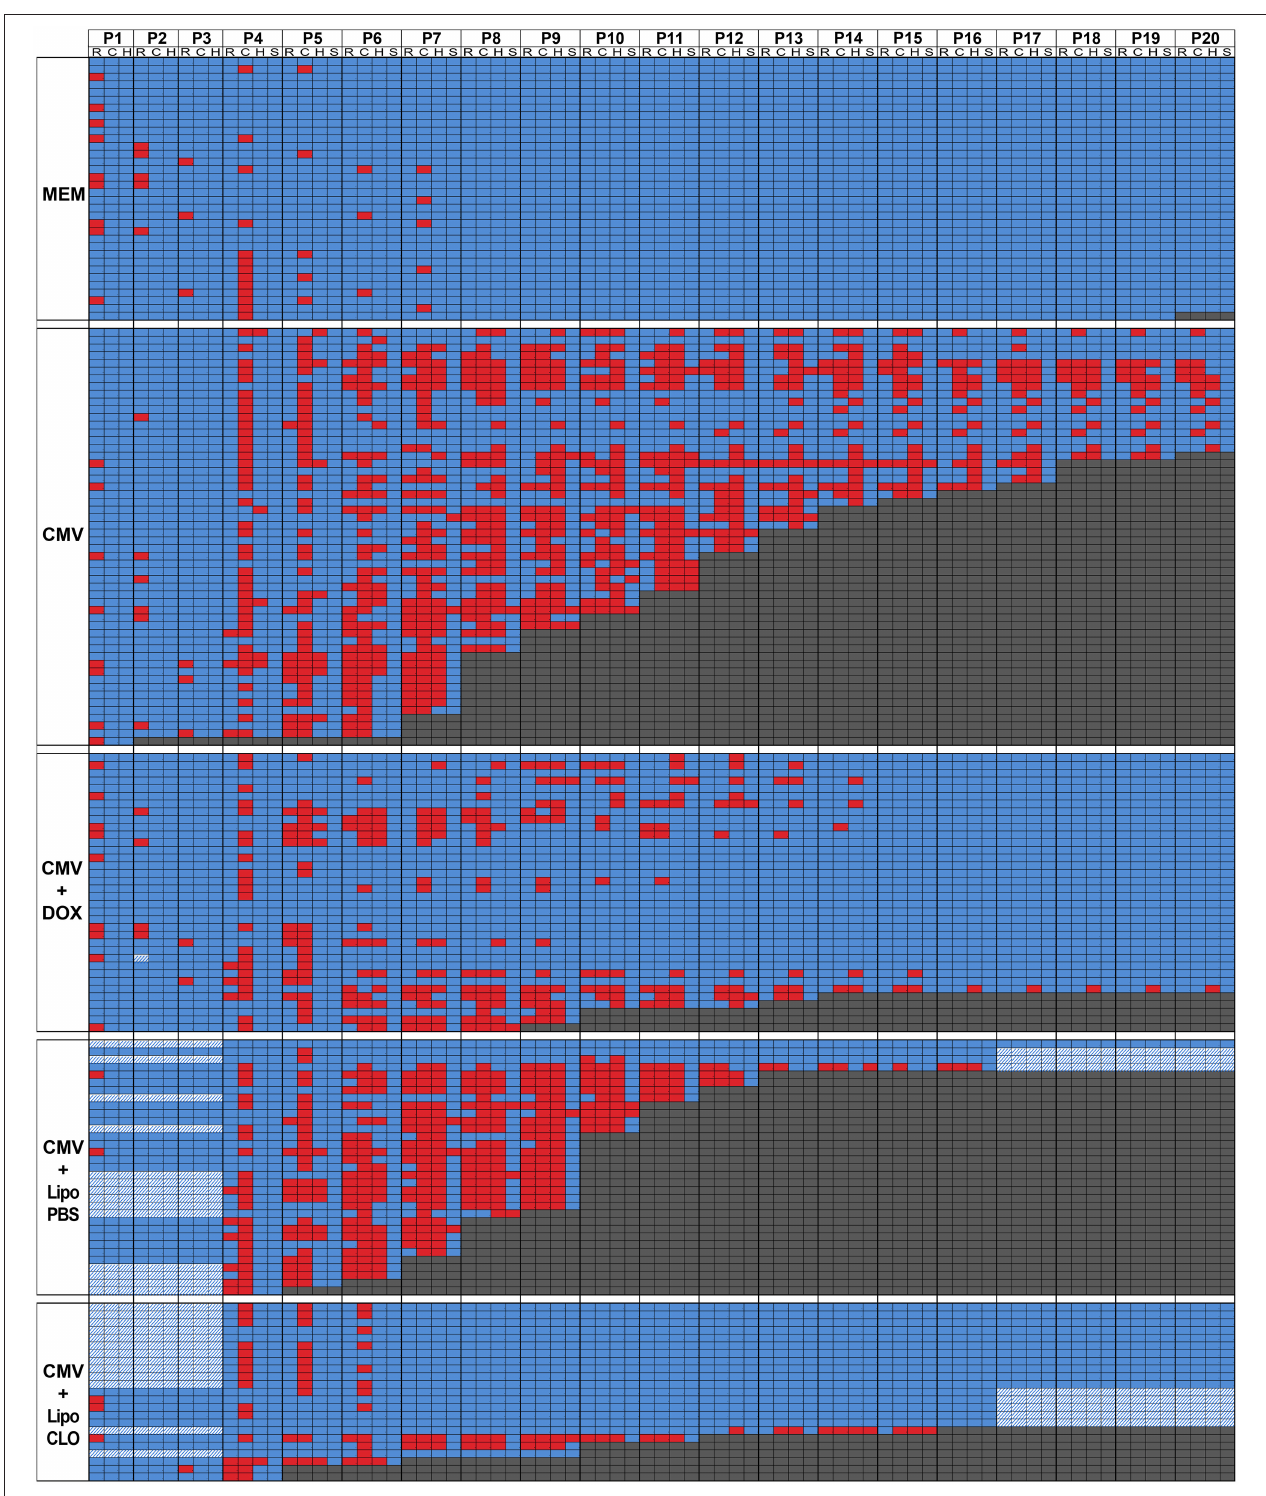
FIGURE 2 | Overview of day-per-day phenotype assessment in the first three postnatal weeks. Color-encoded overview of postnatal test evaluations and observations performed as from postnatal day P1 (see also Figure 1 ; Supplementary Table 1). Five experimental cohorts of rats were analyzed postnatally: i/control embryos were injected intraventricularly (icv) with vehicle at E15 (MEM; n = 34 from four litters); ii/embryos were injected icv with rat CMV at E15 and were born from dams fed with